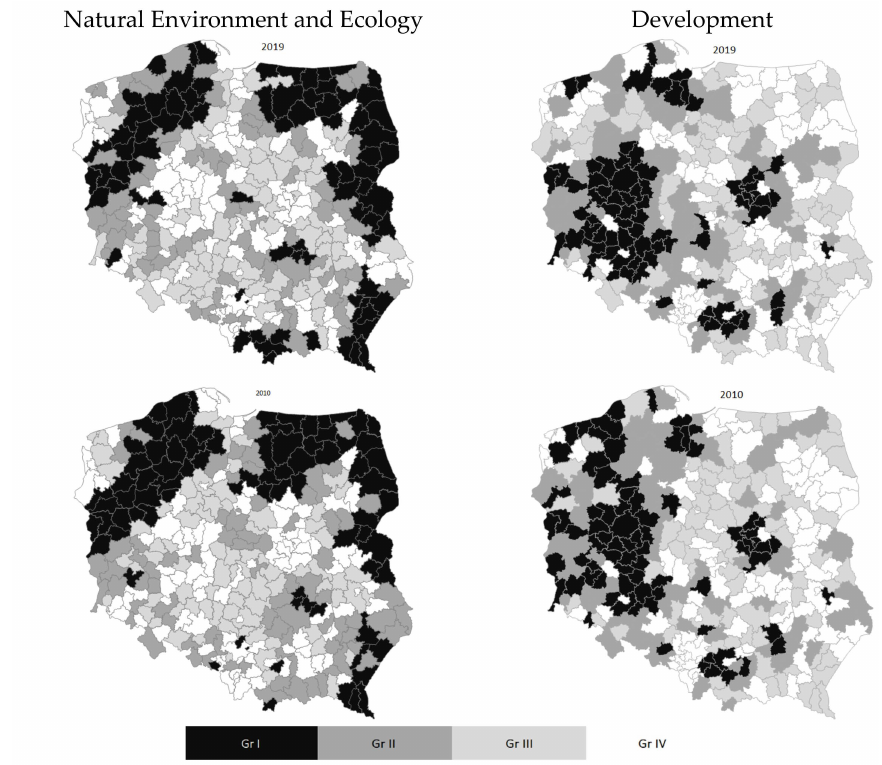
Figure 5. Quartile groups for measures of synthetic development as well as the natural environment and ecology of poviats in Poland in 2010 and 2019 according to the value of local Moran’s I statistics. Source: study based on BDL CSO